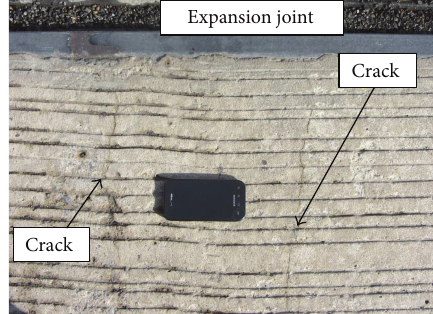
Figure 1: Early age longitudinal concrete cracking on concrete adjacent to bridge deck dam rehabilitations (cell phone: 4.5 × 2 inches for